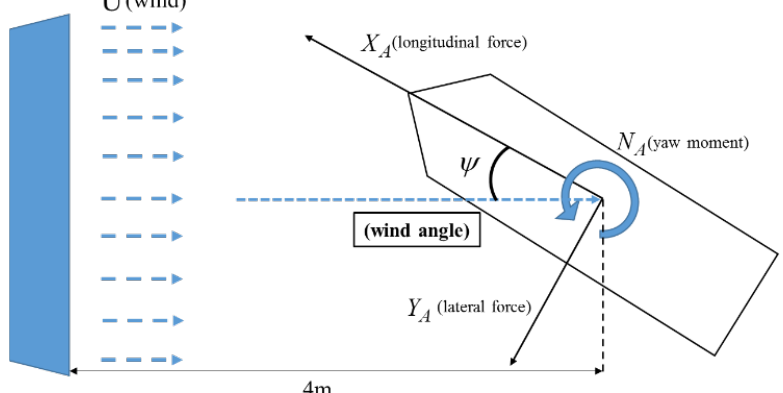
Figure 3. Coordinate system with wind direction.